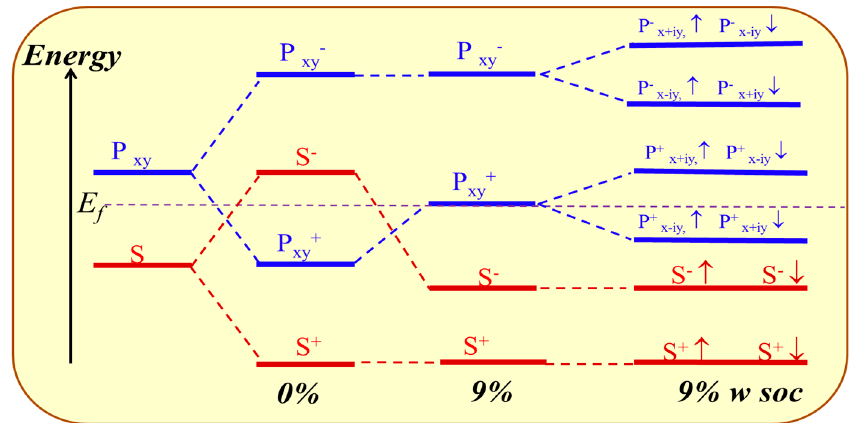
Figure 8. The evolution of atomic s and p xy orbitals of GeH at Γ point described as crystal field splitting and SOC switched on sequence with ε = 0% and ε = 9%. The horizontal dashed lines indicate the Fermi energy.